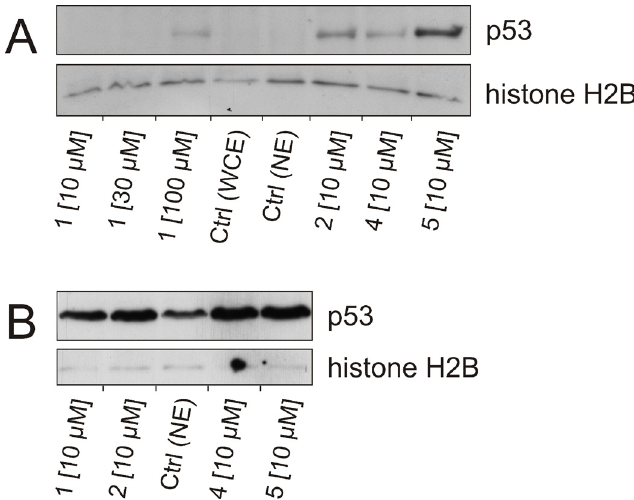
Fig 4. Effect of 1, 2, 4 and 5 on the expression of p53 in NCI-H460 and HT-29 cells. Western blot of p53 and histone H2B (loading control) of NCI-H460 (A) and HT-29 (B) cells. A : Nuclear extracts of NCI-H460 cells, incubated with different concentrations of 1 (10, 30 and 100 μ M) or 10 μ M of 2 , 4 , or 5 for 24 hours. Nuclear extracts (NE) and whole cell lysates (WCE) of untreated cells were used as control (Ctrl). B : Nuclear extracts of HT-29 cells, incubated with 10 μ M of 1 , 2 , 4 , 5 for 24 hours. Untreated cells served as control (Ctrl).